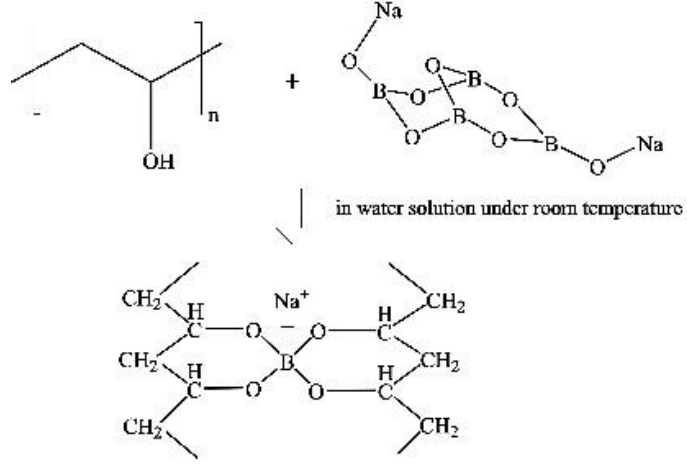
Figure 5. Diagram of the cross-linking reaction between boric acid and PVA.